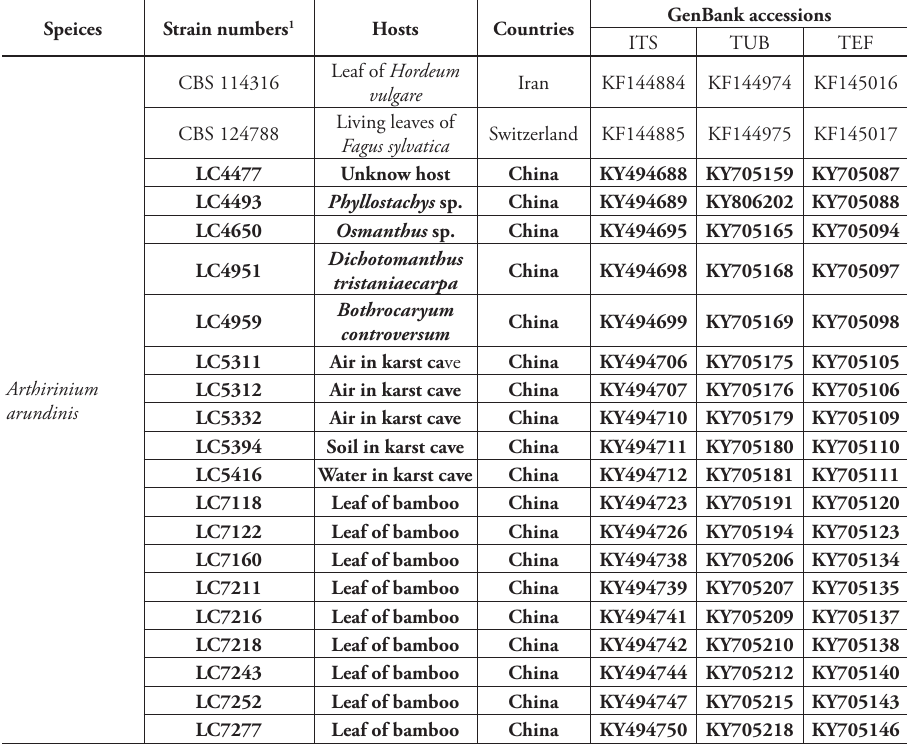
Table 1. Strains included in the phylogenetic analyses.